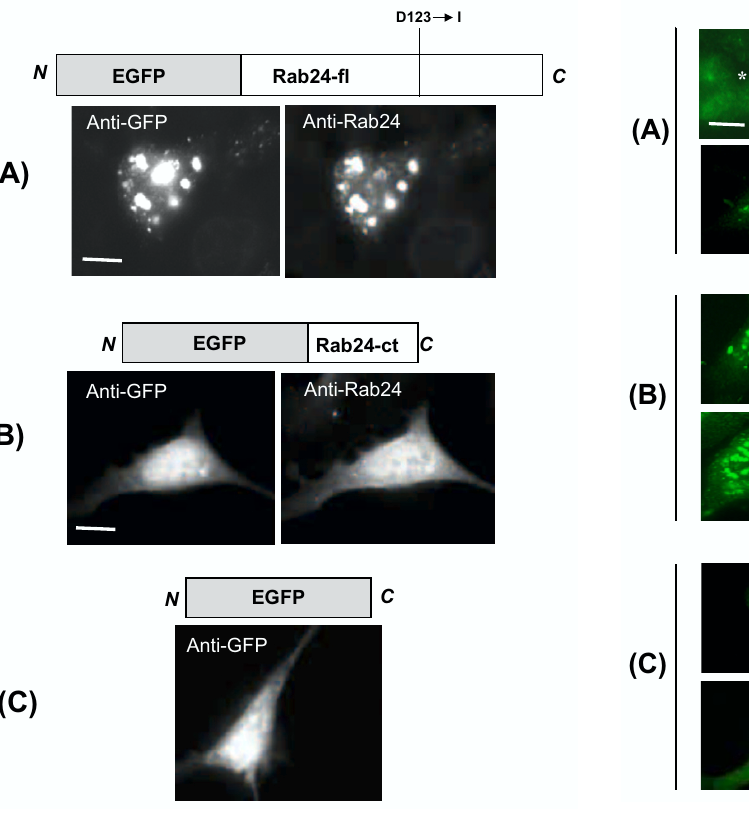
Figure 9 Localization of enhanced green fluorescent protein (EGFP) Rab24 fusion proteins. HEK293 cells were trans- fected with pCMV5 expression vectors encoding: (A) EGFP fused to full-length (fl) Rab24(D123I), (B) EGFP fused to the Rab24 C-terminal hypervariable domain (ct), or (C) EGFP alone. Cells were processed for immunofluorescence micro- scopy 24 h after transfection. The EGFP proteins were local- ized with a monoclonal antibody against green fluorescent protein (GFP) followed by FITC-conjugated GAM IgG. The Rab24 sequence was detected in the same cells with a rabbit polyclonal antibody against the C-terminal domain, followed by rhodamine-conjugated GAR IgG. The bar represents 10 microns.